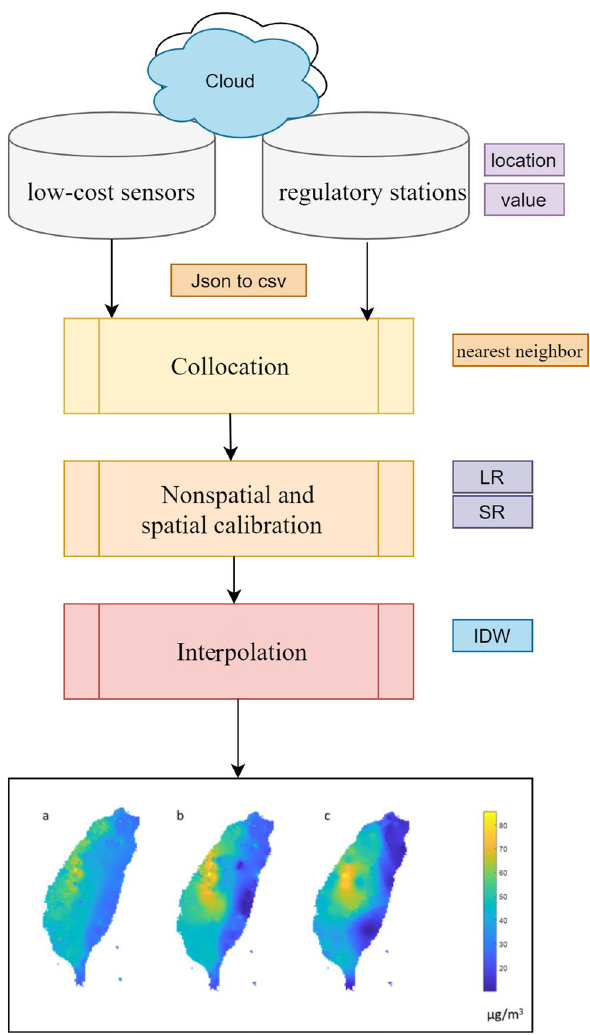
Figure 2. Study flowchart including data preprocessing, e.g., json to csv, data collocation, nonspatial and spatial calibration models, i.e., linear regression (LR) and spatial regression (SR), spatial interpolation, and mapping (IDW: inverse distance weighting). The bottom plot was created in MATLAB_R2018B (https ://www.mathw orks. com/produ cts/matla